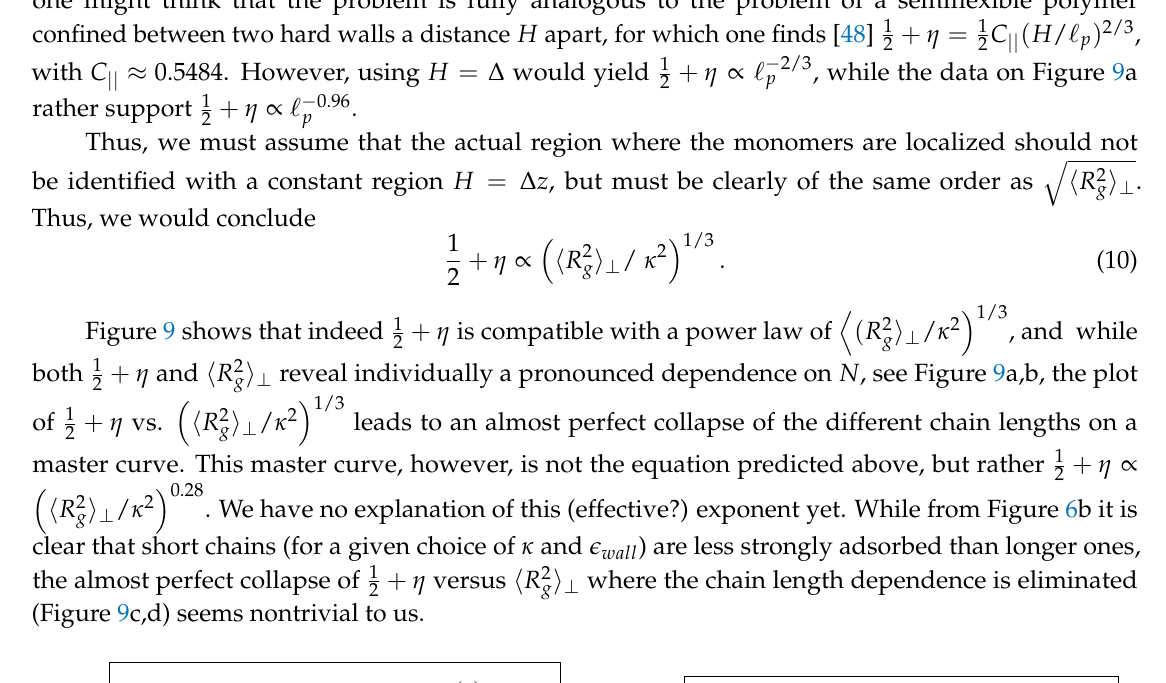
(cid:16) (cid:17) 1/3 (cid:104) R 2 (cid:105) ⊥ / κ 2 for (cid:101) wall = 0.80; g